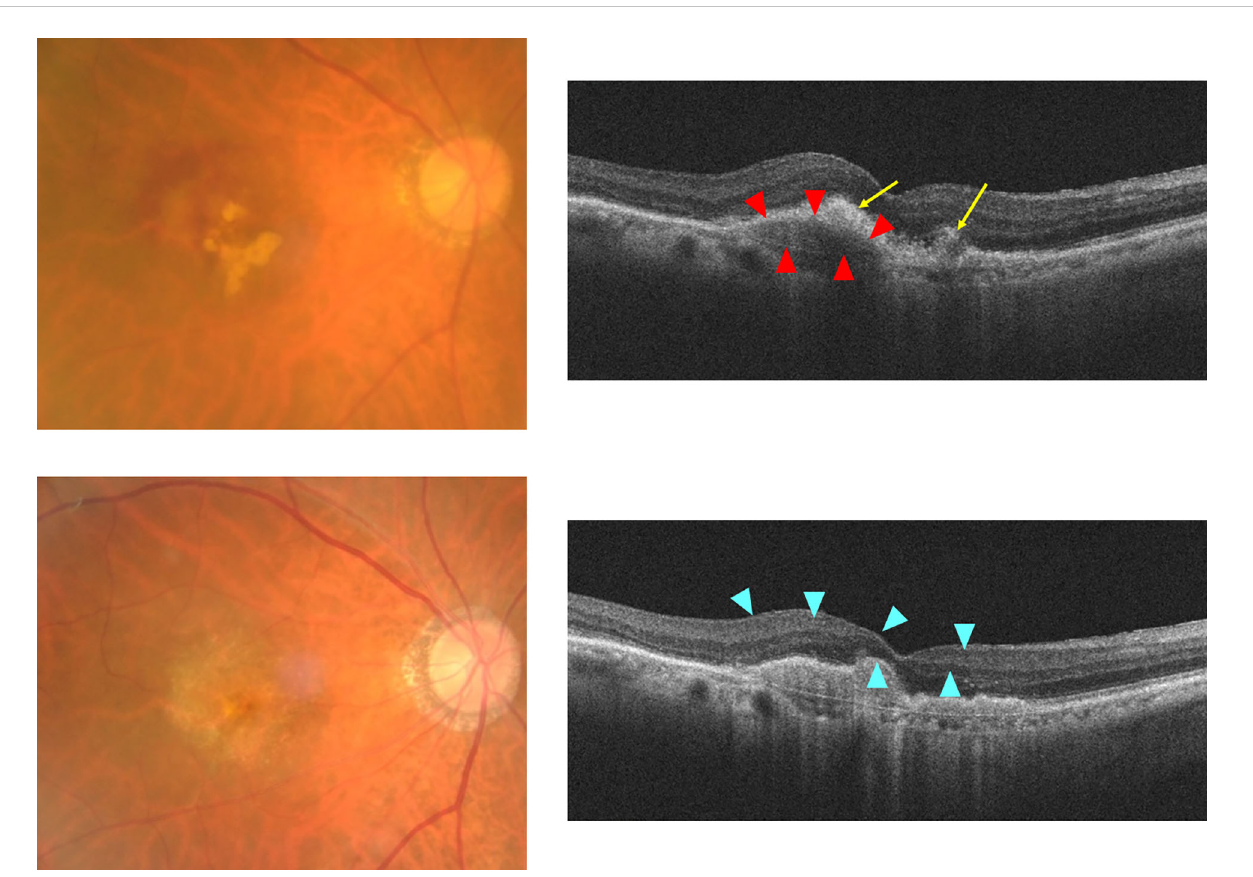
FIGURE 1 Formation of SHRM during anti-VEGF therapy for nAMD case. Upper: before treatment, Lower: 12 months after fi rst treatment. Right: fundus color photo, Left: optical coherence tomography (OCT) image. Grayish-white neovascular vessels with small amounts of hemorrhage and white exudative lesions are observed in the macula of the left eye before anti-VEGF therapy. The OCT image shows RPE elevation due to fi brovascular membrane with choroidal neovascularization (red arrowheads), surrounding the hyperre fl ective lesion (yellow arrows) with an indistinct margin suggestive of hemorrhage and fi brin deposition. Twelve months after initial treatment, white fi brosis tissue and depigmentation associated with retinal atrophy were observed. OCT images show the formation of sharply marginated SHRM (blue arrowheads) above the Bruch ’ s membrane at the